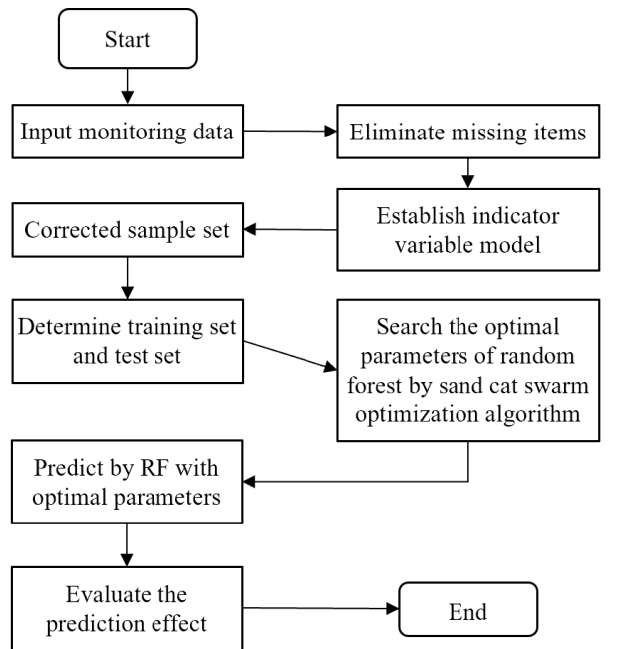
Figure 4. Operation process of concrete dam deformation prediction system based on IVM-SCSO-RF.